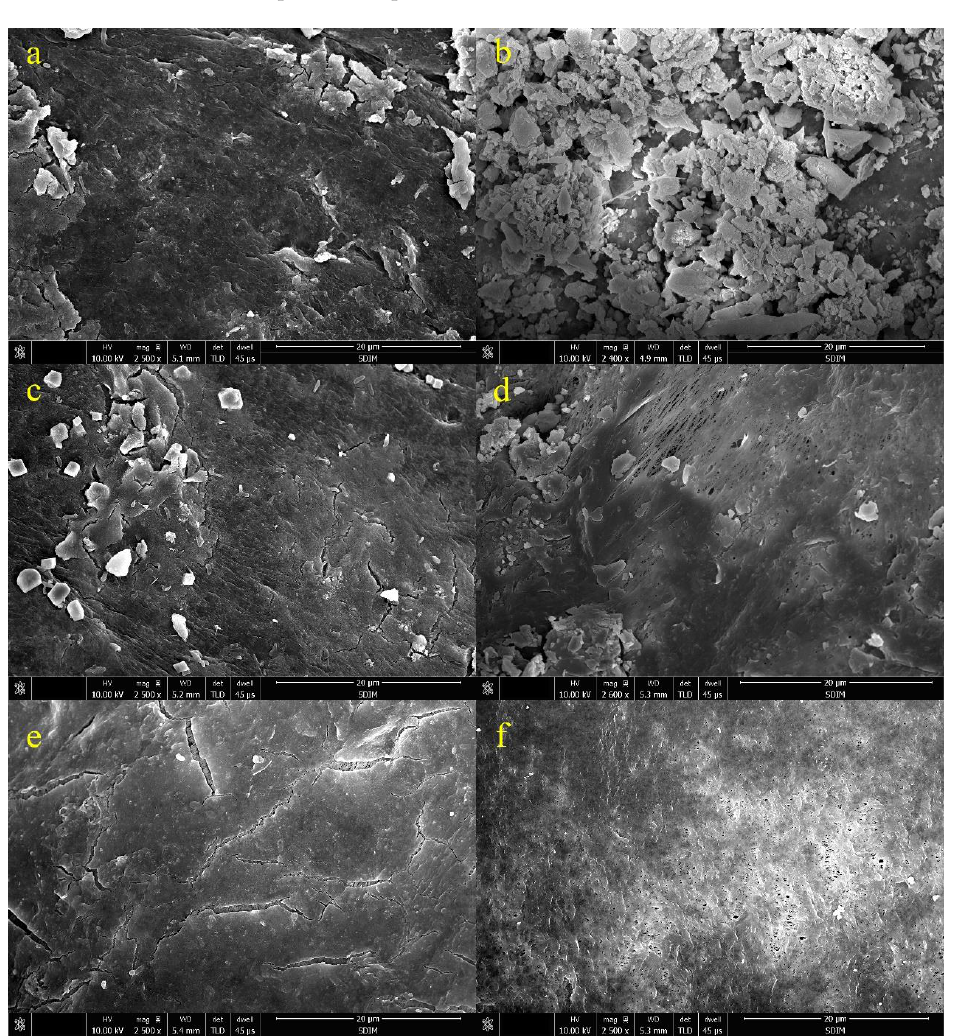
Figure 7. SEM images of membrane surfaces ( a ) coagulation ultra-filtration (C-UF) ( b ) adsorption ultra-filtration (A-UF) ( c ) coagulation ultra-filtration (C-A-UF) ( d ) coagulation and adsorption ultra-filtration (C+A-UF) ( e ) ultra-filtration (UF) alone ( f ) New membrane.